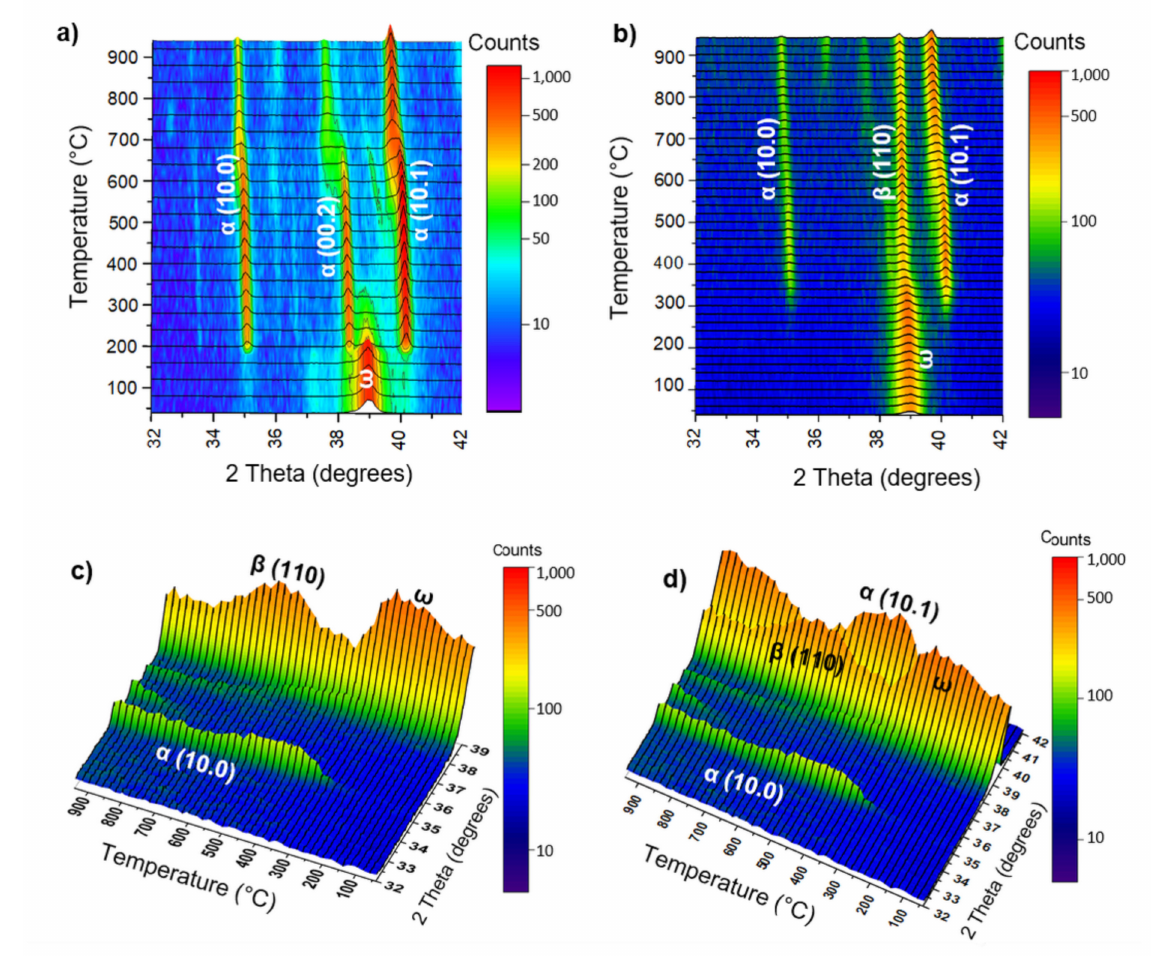
Figure 5. The XRD in situ heating map of the HPT-deformed Ti–3wt.% Nb ( a ) and Ti–20wt.% Nb ( b – d ) alloys. The ω -phase is presented by a (11.0 + 10.1) doublet of peaks at the angle of 2 θ 39.09 ◦ . Lateral projections ( c , d ) of the map shown in ( b ) in the 32–39 ◦ ( c ) and 32–42 ◦ ( d ) range of 2 θ angles. Figure 5a is reprinted with permission from Reference